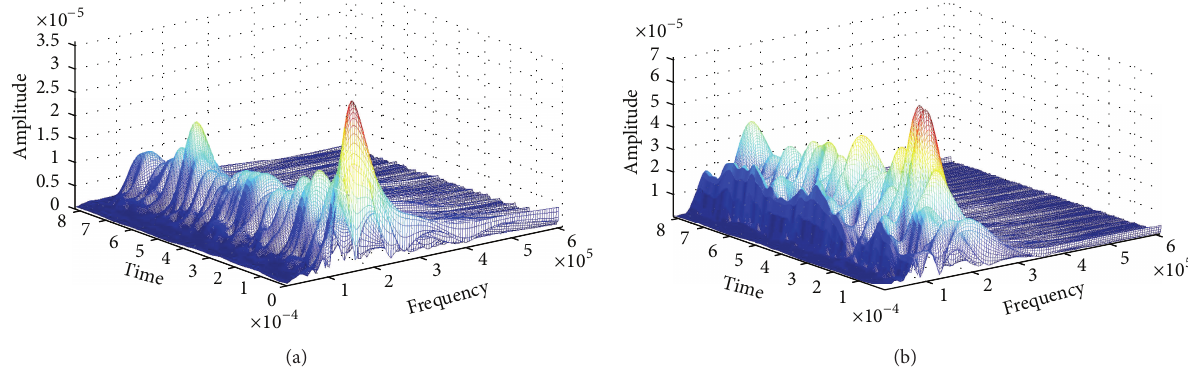
Figure 6: Fatigue crack initiation (a) base metal and (b) welded specimen.